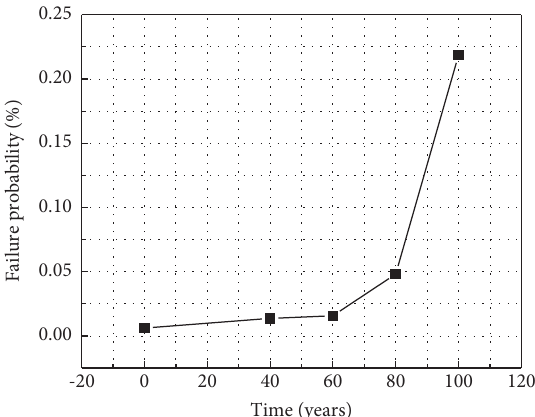
Figure 8: Trends in ship-crash time-dependent failure probabilities.